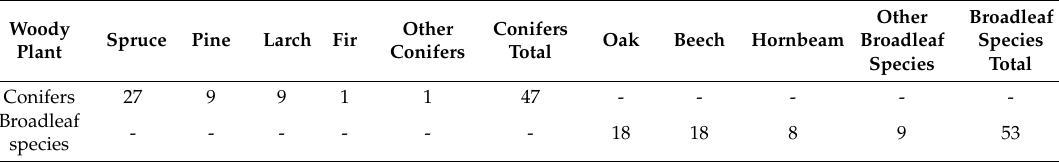
Table 1. Current woody plant composition of the area of K ř ivoklátsko LP in % [4].